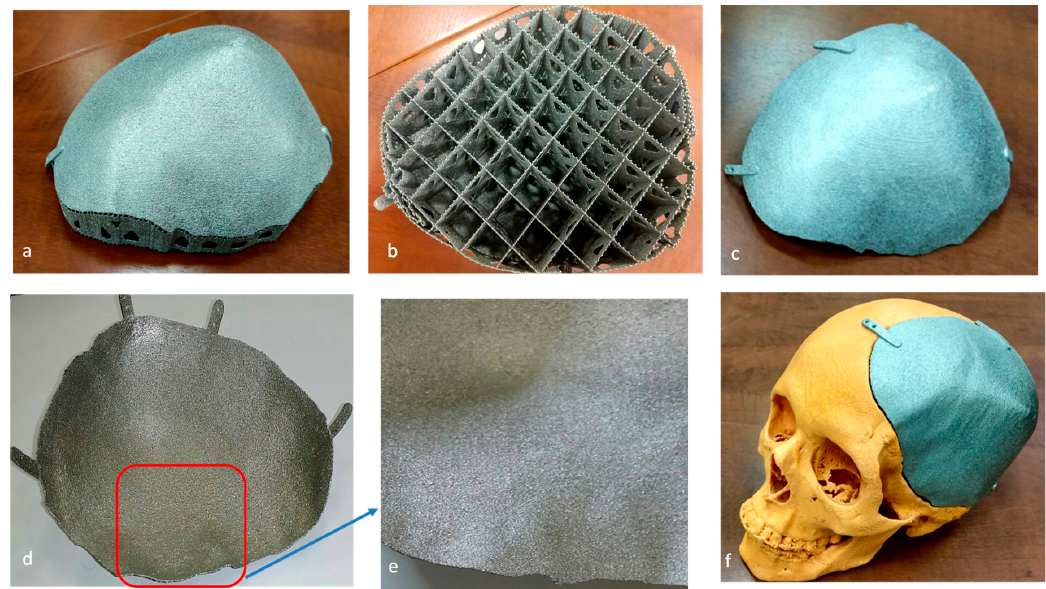
Figure 11. EBM Fabricated parts: ( a ) Top view of titanium cranial implant with supports; ( b ) Bottom view showing support structures; ( c ) Top view of cranial implant after support removal; ( d ) bottom view after support removal; ( e ) Enlarged view illustrating no burr or protrusion and ( f ) Cranial implant fitting rehearsal on a polymer skull model.